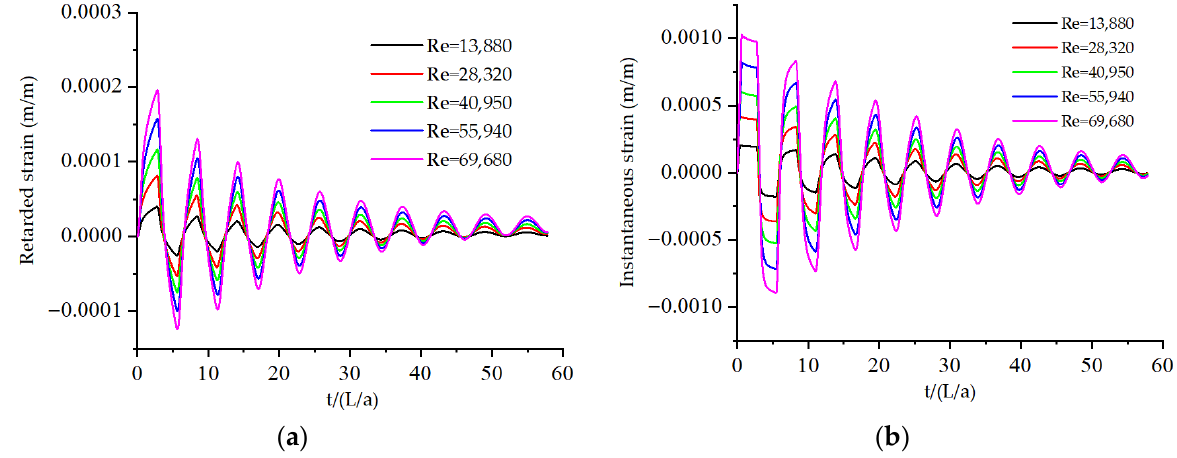
Figure 4. Variation of ( a ) retarded and ( b ) instantaneous strain at different Re values.